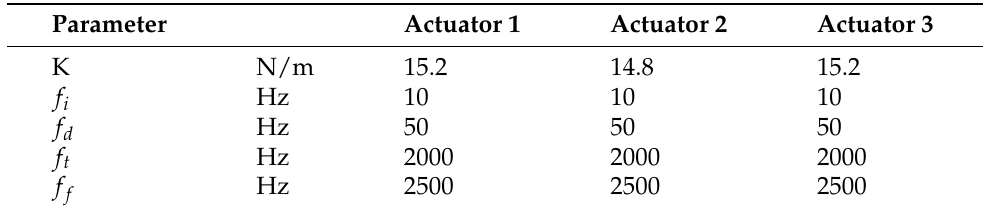
Table 2. ILC-PID parameters.